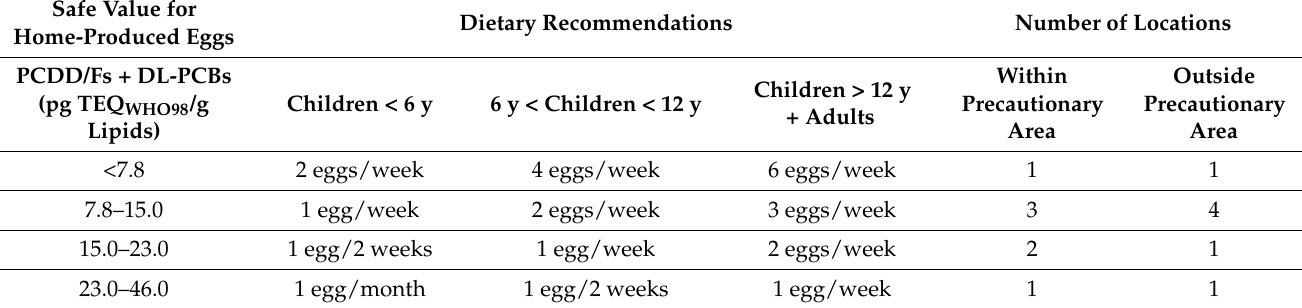
Table 5. Calculated values for safe consumption of home-produced eggs, with corresponding dietary recommendations and number of measurement locations in each category.